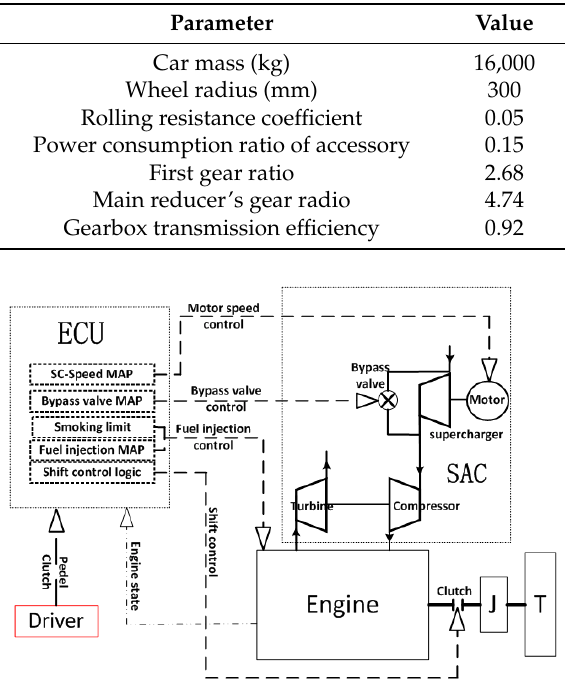
Table 5. Vehicle Specifications.